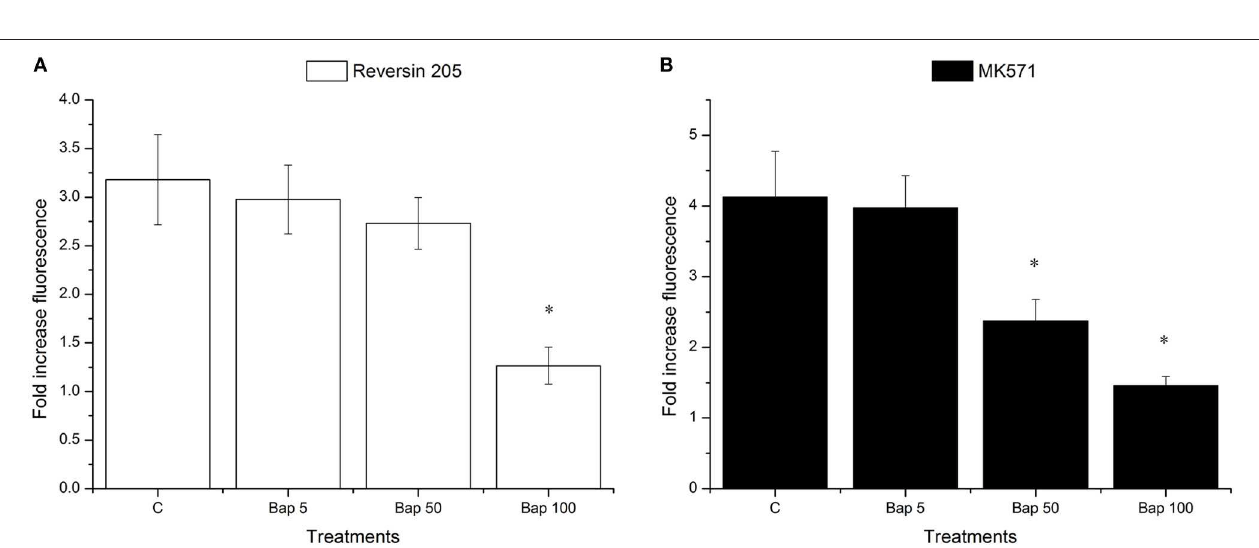
FIGURE 5 | Expression profiles of Mco ABCB1 (A) and Mco ABCC (B) in response to Bap exposure in gills. Data are presented as mean ± S.D ( n = 3 per group). Different letters indicate significant differences ( P < 0.05).